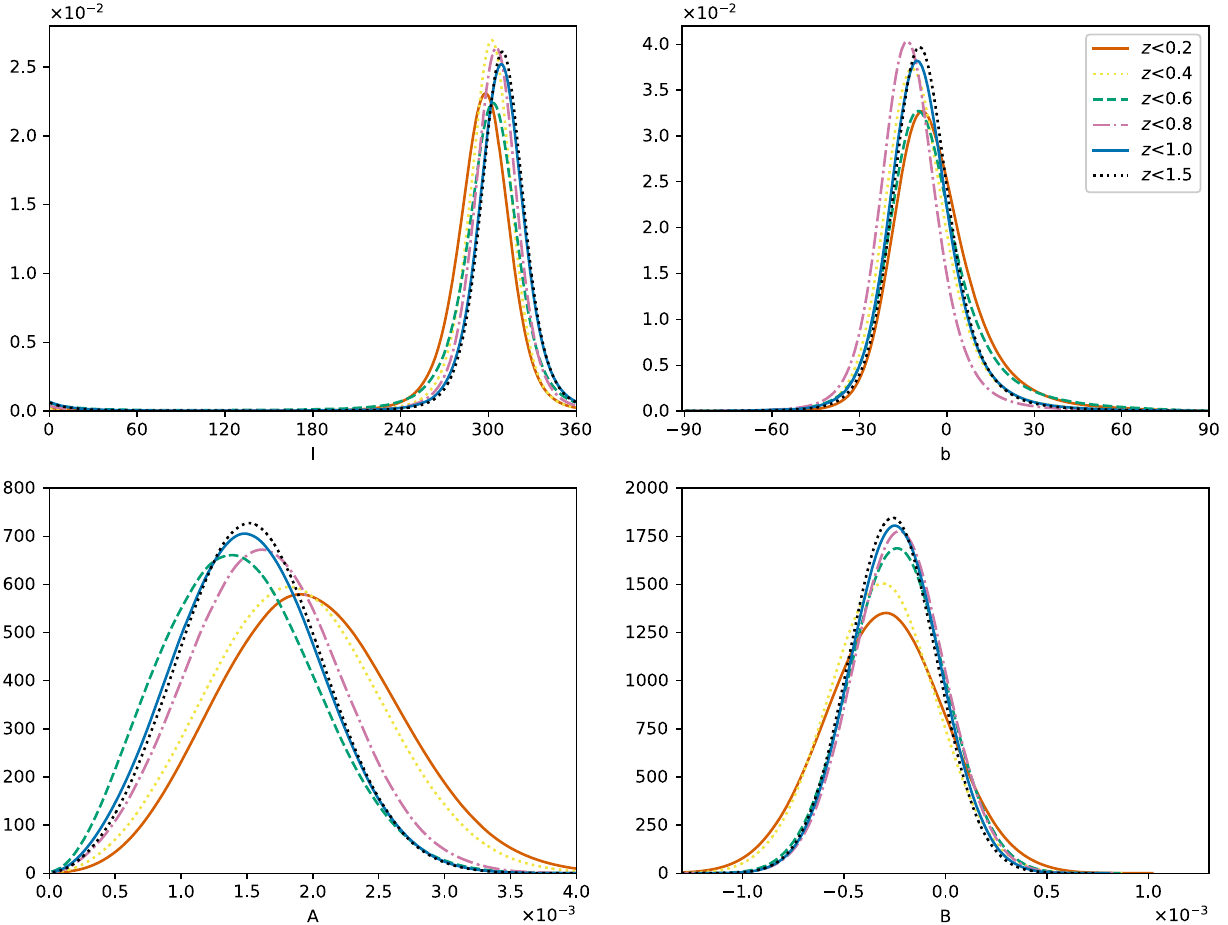
Fig. 11 Marginalized likelihoods of dipole A , monopole B and ( l , b ) for different redshift range of Union2.1 data set